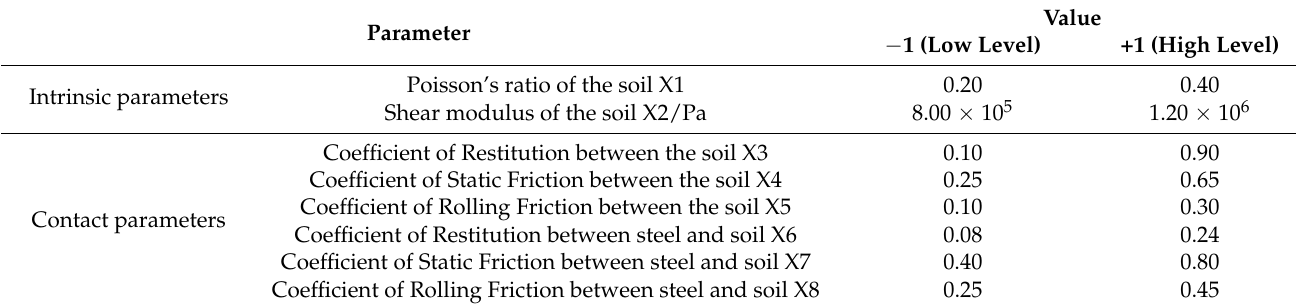
Table 2. The Code table of Regular Two-Level Factorial Design experiment.